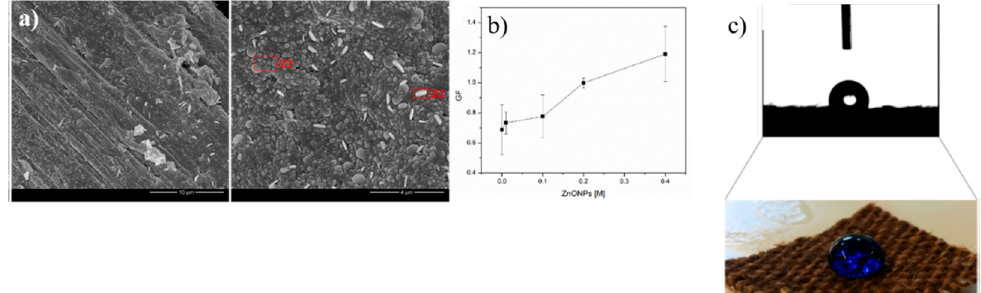
Figure 4. FESEM images of flax fabric functionalized with both Ag and ZnO NPs ( a ). Gauge Factor (GF) values for the flax fabrics functionalized with different ZnO NPs concentrations ( b ). WCA measurements of the flax fabrics functionalized with Ag and ZnO NPs ( c ) [79].